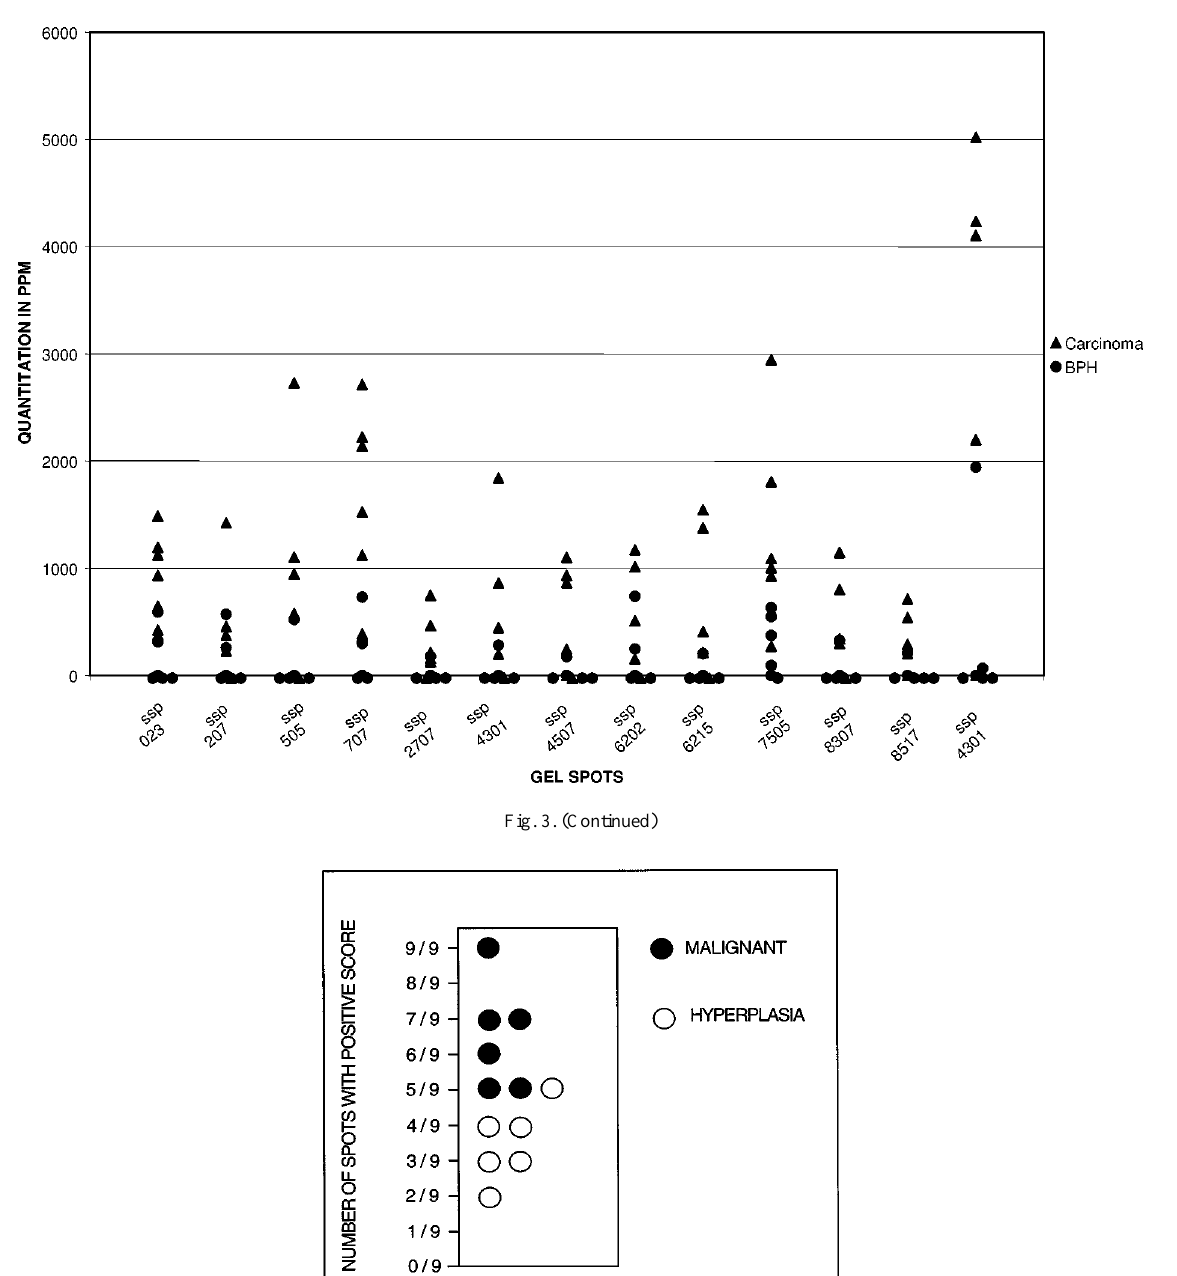
Fig. 4. Scores of the expression of 9 different protein markers in individual tumors. Cut-off values for the classification of expression of each markers to be negative or positive have been previously established for ovarian carcinoma [1], and the same cut-offs were used here. The number of proteins expressed in each tumor at levels beyond the cut-off level are indicated (9/9 meaning that all proteins were expressed beyond the cut-off level). The 9 proteins were PCNA, TM-1, TM-2, calreticulin, HSP-60, HSP-90, cytokeratin 18, TPI and elongation factor 2. nant pattern of expression of 5 or more of the 9 mark- The abundance of mRNA transcripts can be ers. By contrast, only 1 benign tumor showed the ma- lignant pattern of expression of 5 markers.